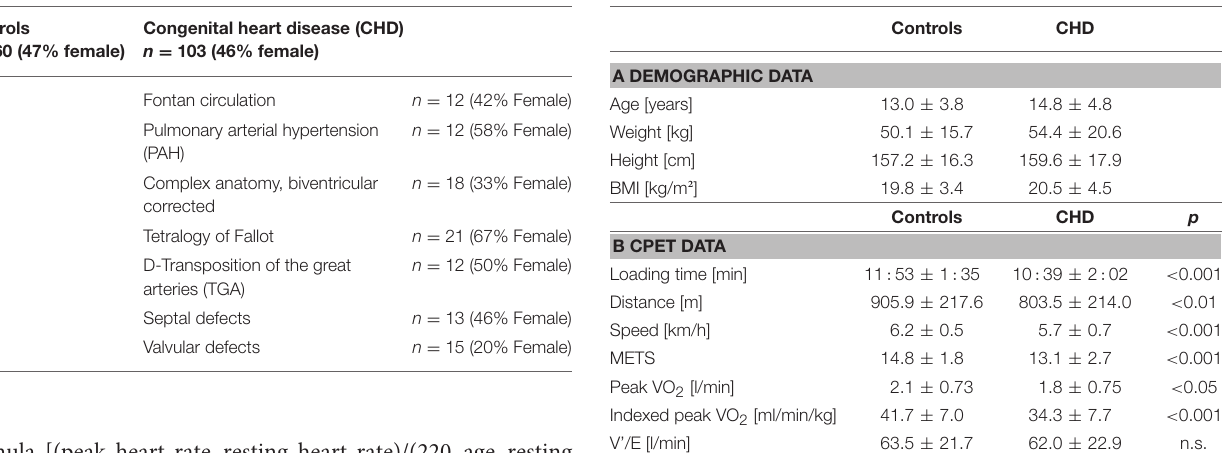
TABLE 1 | Study group characteristics. TABLE 2 | Demographic and CPET data.